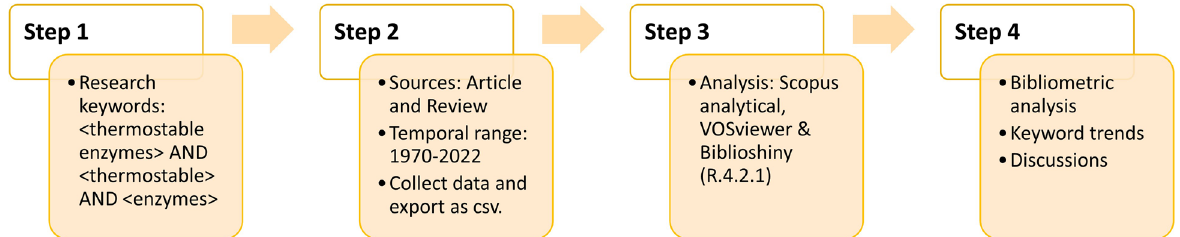
Fig. 1 Flowchart of bibliometric search strategy